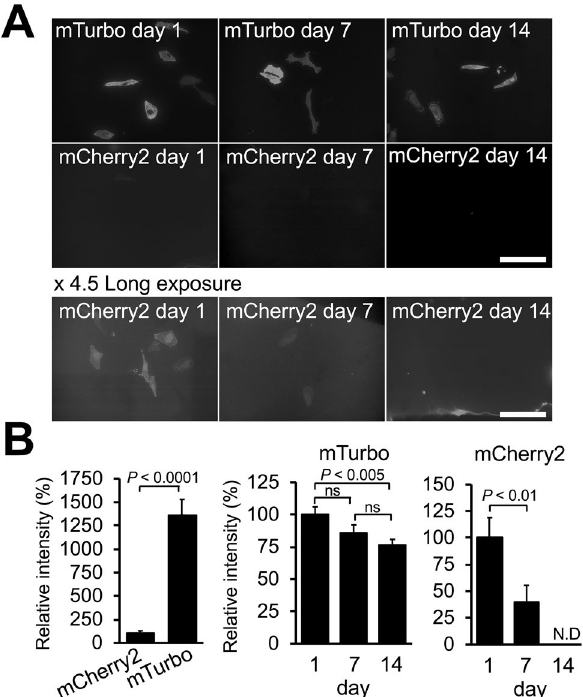
Figure 4. Fluorescent signals in ultrathin sections of in-resin CLEM using a biotin ligase were brighter and more stable than those with a fluorescent protein, mCherry2. ( A ) Time-dependent decreases in fluorescent signals of fluorophore-labeled biotinylated proteins in the 100-nm thin sections of Epon-embedded cells. Fluorescent images of biotinylated proteins in the sections of Epon-embedded cells were obtained by fluorescence microscopy ( upper panels, mTurbo ). Fluorescent images of mCherry2 in the sections of Epon- embedded cells expressing mCherry2 are shown in the middle and lower panels. In the middle panels, fluorescent images were obtained under the same conditions for mTurbo using a BZ-X810 fluorescence microscope (CCD monochrome camera, Nikon CFI Plan Apochromat × 40 lens, gain + 16 dB, 2 × 2 on-chip binning, exposure time 1/1.5 s) using a filter set (excitation: 520–570 nm, dichroic mirror: 565 nm long pass, emission: 535–675 nm). Images in the lower panels ( Long exposure ) were 4.5 × longer exposure of those in the middle panels. Note that fluorescence of proximity-labeled Epon-embedded cells ( mTurbo ) was brighter than that of mCherry2 -expressed Epon-embedded cells. ( B ) Evaluation of brightness and stability in the 100-nm thin sections of the proximity-labeled Epon-embedded cells. The relative intensity of fluorescence mediated by mTurbo was compared with that of mCherry2 ( left graph). Time-dependent decreases of fluorescence in the thin sections of mTurbo - and mCherry2 -expressed Epon-embedded cells were evaluated at 1, 7, and 14 days after preparation of the sections ( middle and right graphs). Relative intensity of fluorescence is shown such that the intensity at day 1 is estimated as 100%. Error bars indicate standard